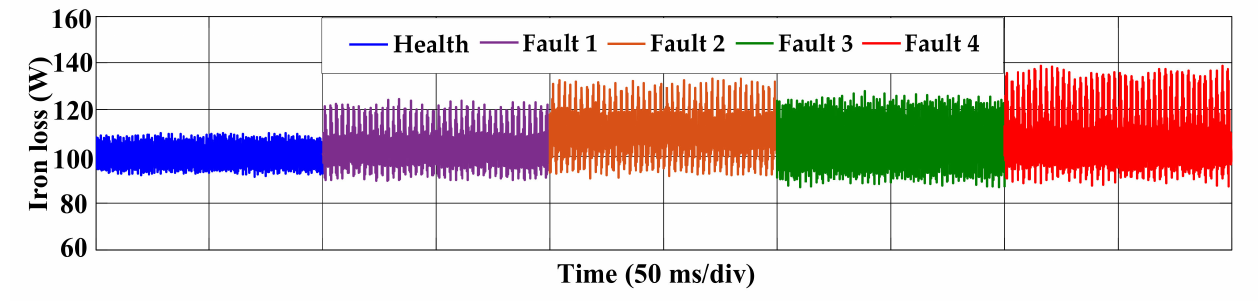
Figure 6. FE results of the iron loss for health and fault conditions under 20 Nm.